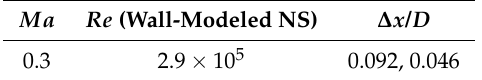
Table 1. Simulation conditions for the flow around a triangular column.